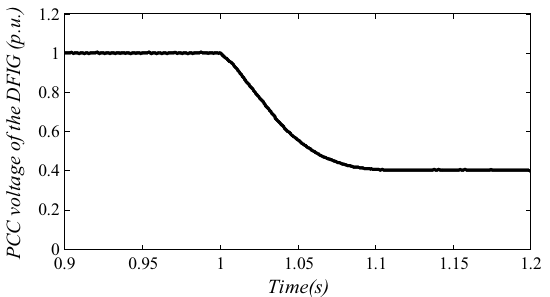
Fig. 6 PCC voltage of the